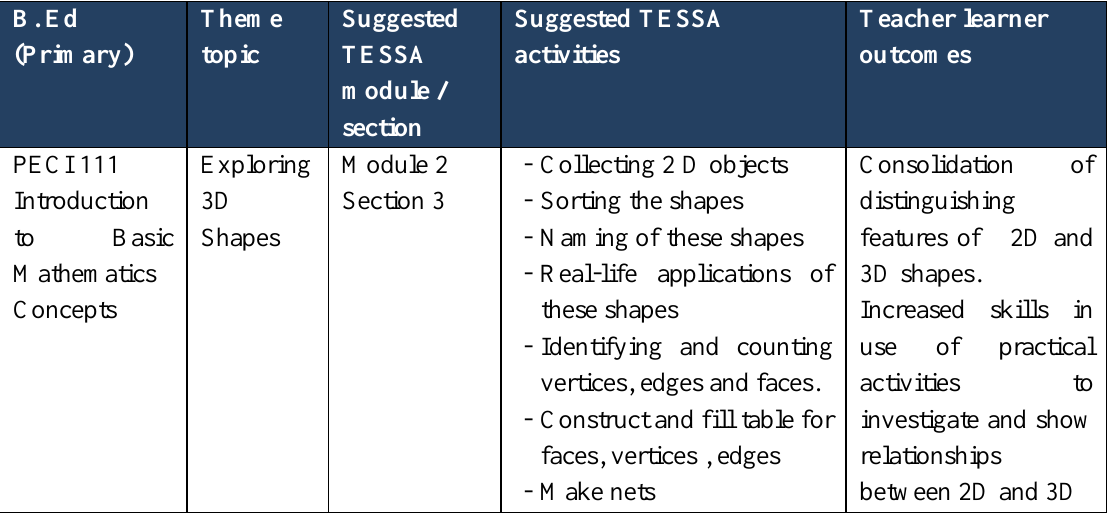
Loosely Structured Model: Example from Egerton University Workshop B.